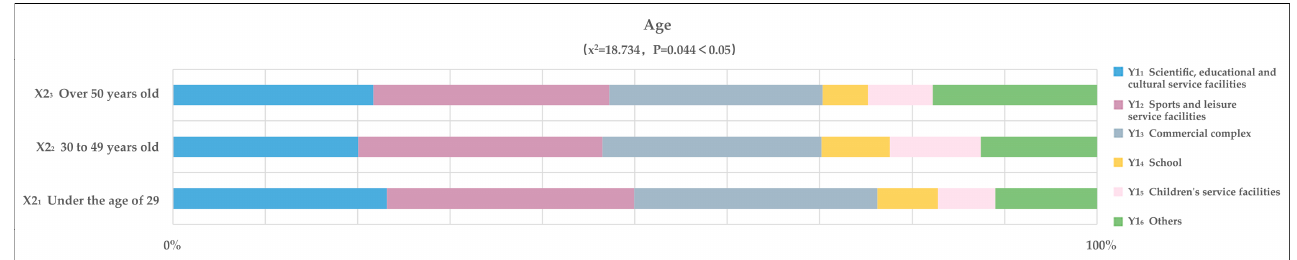
Figure 11. Demand from di ff erent age groups.